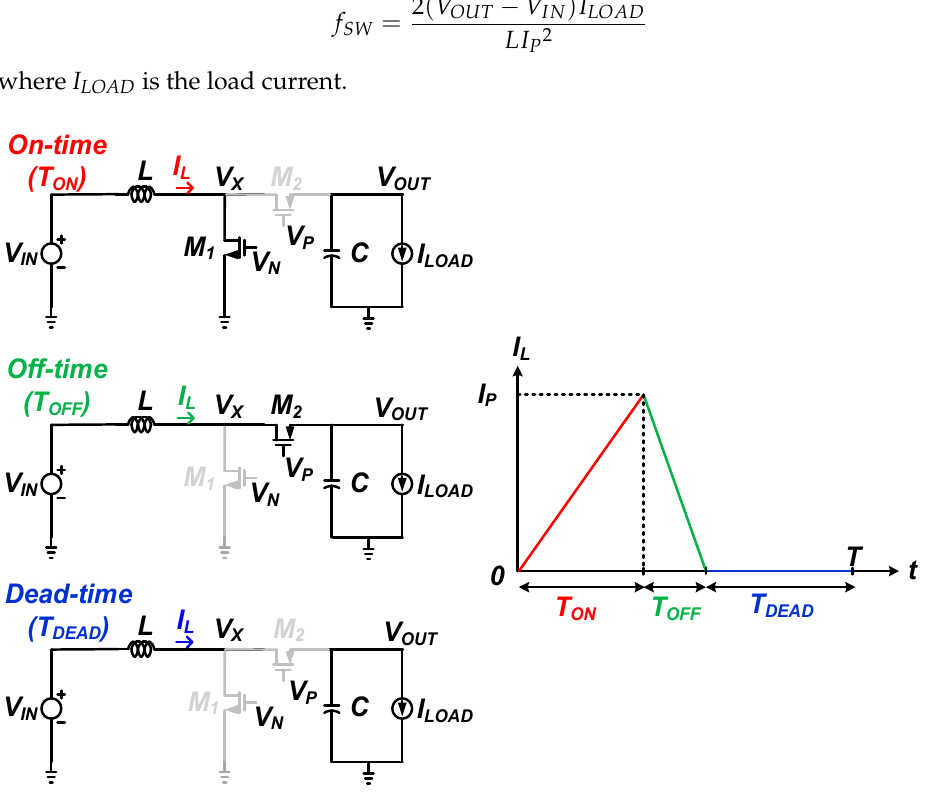
Figure 3. DCM operation and inductor current ( I L ) waveform of DC-DC boost converter.